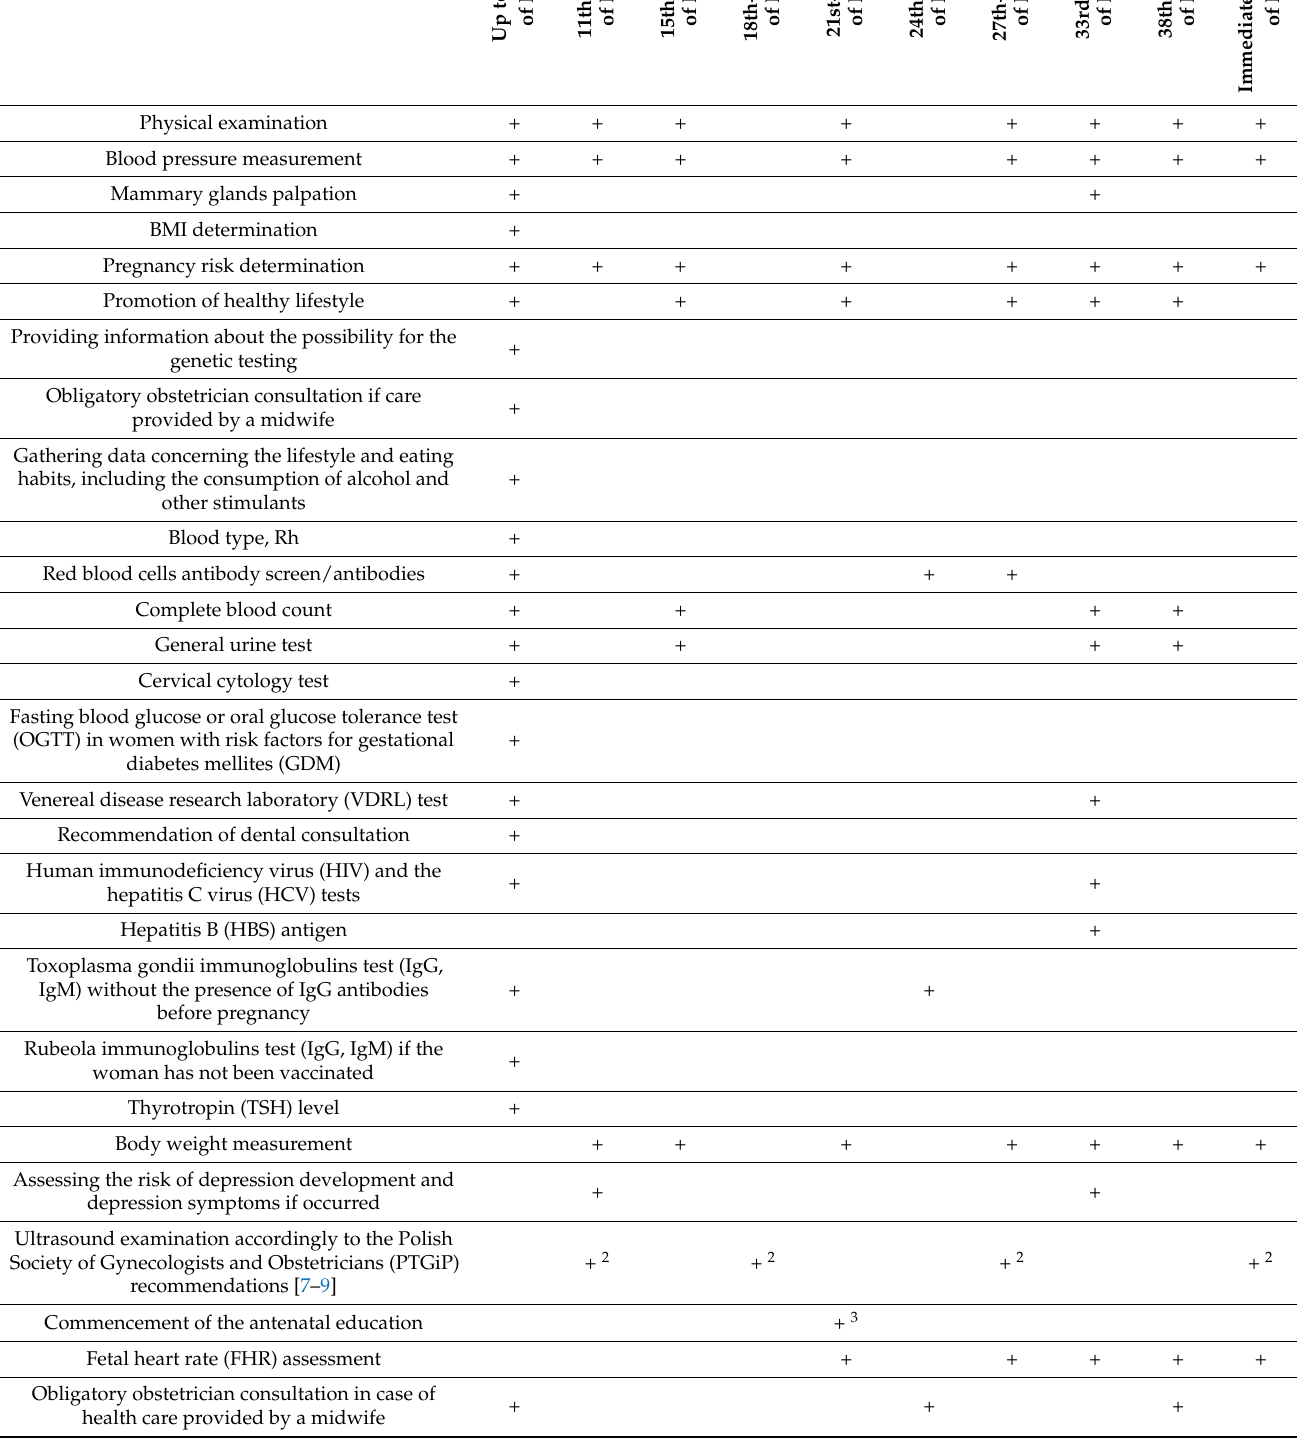
Table 1. Mandatory preventative services, diagnostic tests, and medical consultations with comments regarding the pandemic state